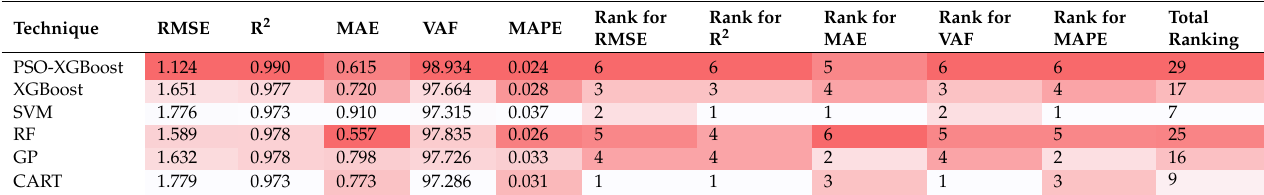
Table 3. The results of the developed model on the testing dataset through several statistical